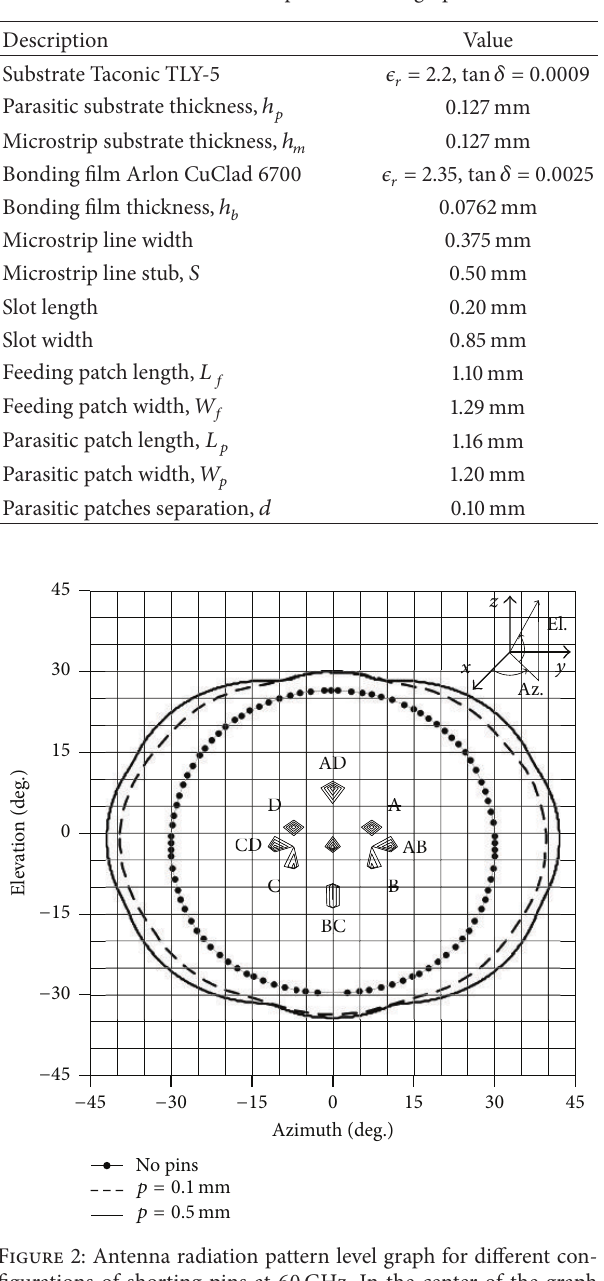
radiation pattern point and the 𝑥 -axis. Elevation is the angle